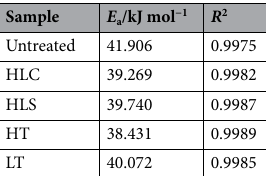
Table 4. The kinetic parameters of HNIW/FOX-7 based PBX samples.